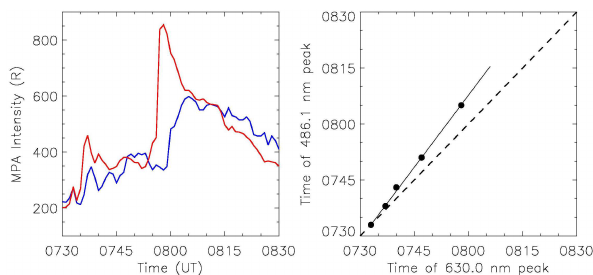
Fig. 14. Left panel shows a plot of the Gillam MSP observations of H β emissions (bin 7) and red-line emissions (average of bin 7 and 8) versus time, while the right panel shows the time delays between the red-line and H β emission maxima.